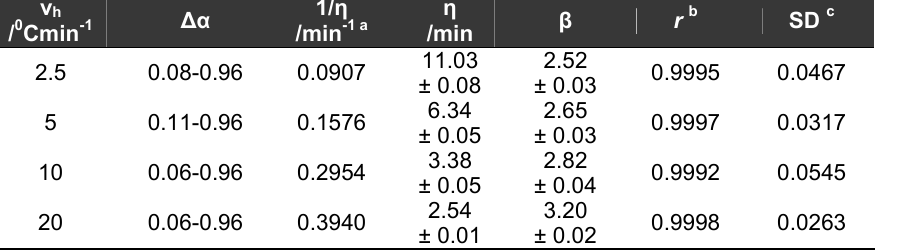
a The rate constant (Konstanta brzine). b Linear correlation coefficient (Koeficijent linearne korelacije). c Standard deviation (Standardna